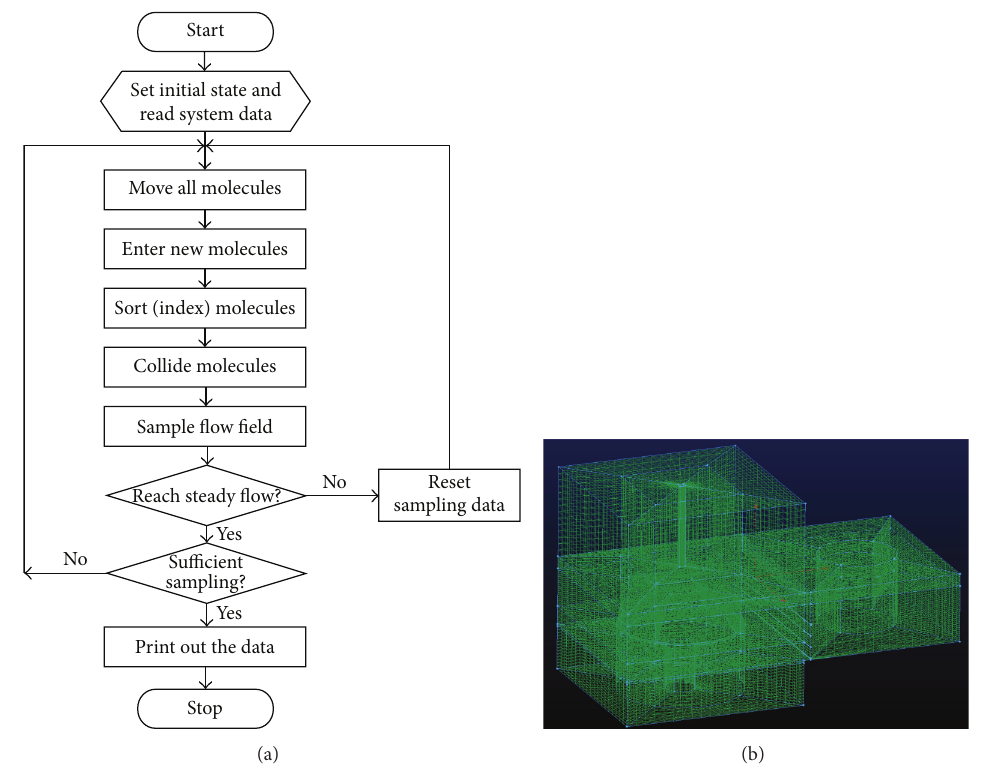
Figure 2: (a) Flow chart of the 3D DSMC method and (b) the 3D simulation